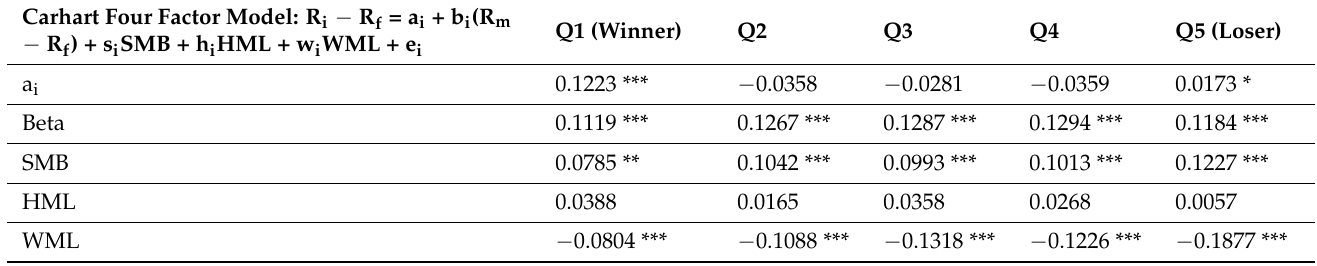
Table 11. Robustness check for Winner and Loser REIT portfolios